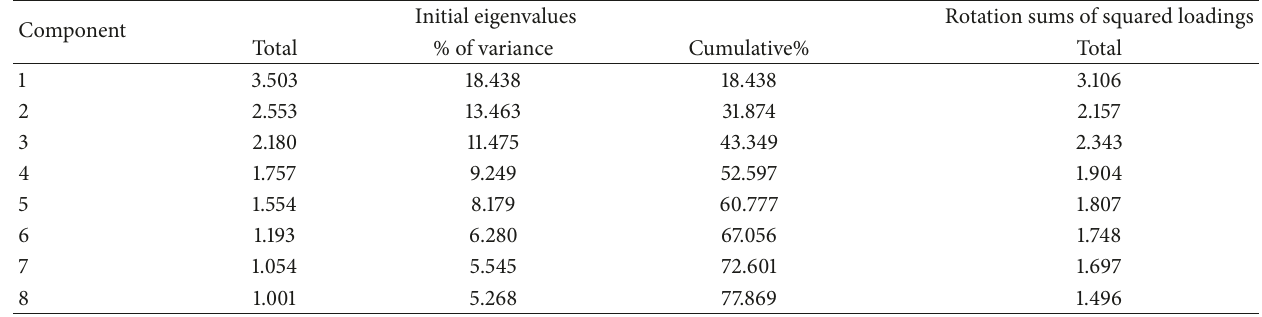
Table 5: Factor analysis beliefs domain: construct validity.